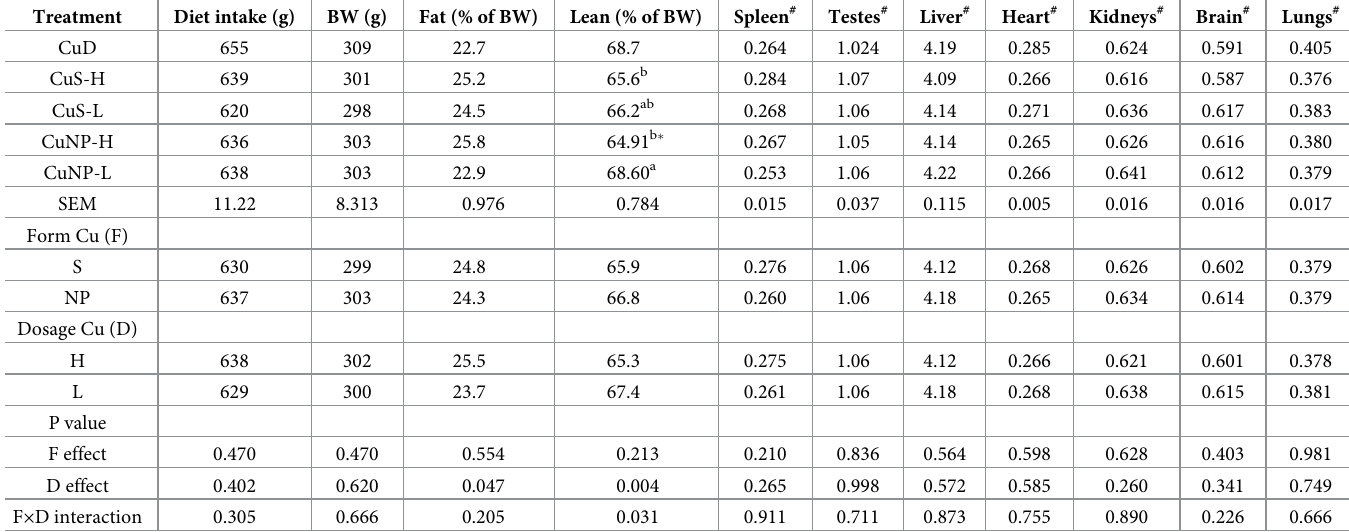
Table 5. Dietary intake, final body weight (BW), proportion of body fat and lean mass, and relative weights of selected internal organ of rats.